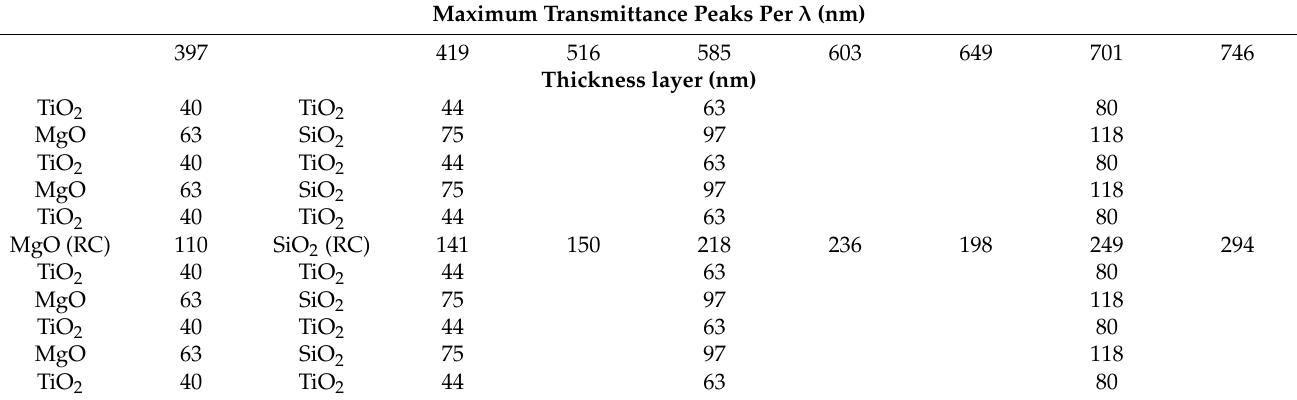
Table 1. Optical filters in the UV/Vis, Vis and Vis/IR spectral regions and respective MgO/TiO 2 and SiO 2 /TiO 2 layer thicknesses (RC: Resonance